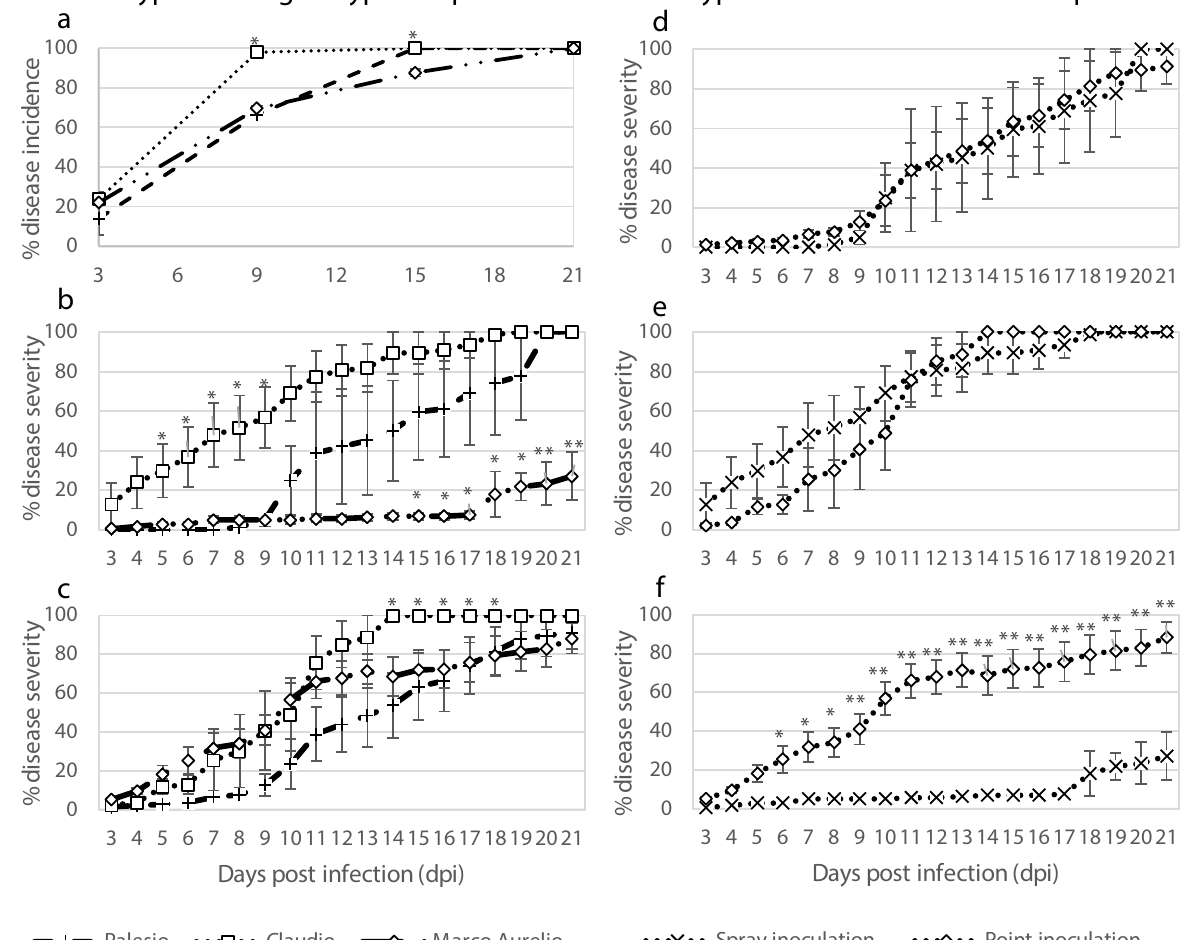
Figure 1. Fusarium graminearum symptom development during 21 dpi, following inoculation of three Italian wheat genotypes with 2,500 conidia per spike. a) % disease incidence (Type I); b) % disease severity after spray inoculation (Type II); c) % disease severity after point inoculation (Type II); d), e) and f) % disease severity (Type II) between spray and point inoculation methods for, respectively, ‘Palesio, ‘Claudio’ and ‘Marco Aurelio’. Data represent averages and standard errors for three independent replicates with at least 20 plants for each genotype × inoculation combination. Statistical analyses were performed according to a one way analysis of variance (ANOVA) with the Tukey test at a 0.95 confidence level and (*) P < 0.05, and at a 0.99 confidence level and (**) P <